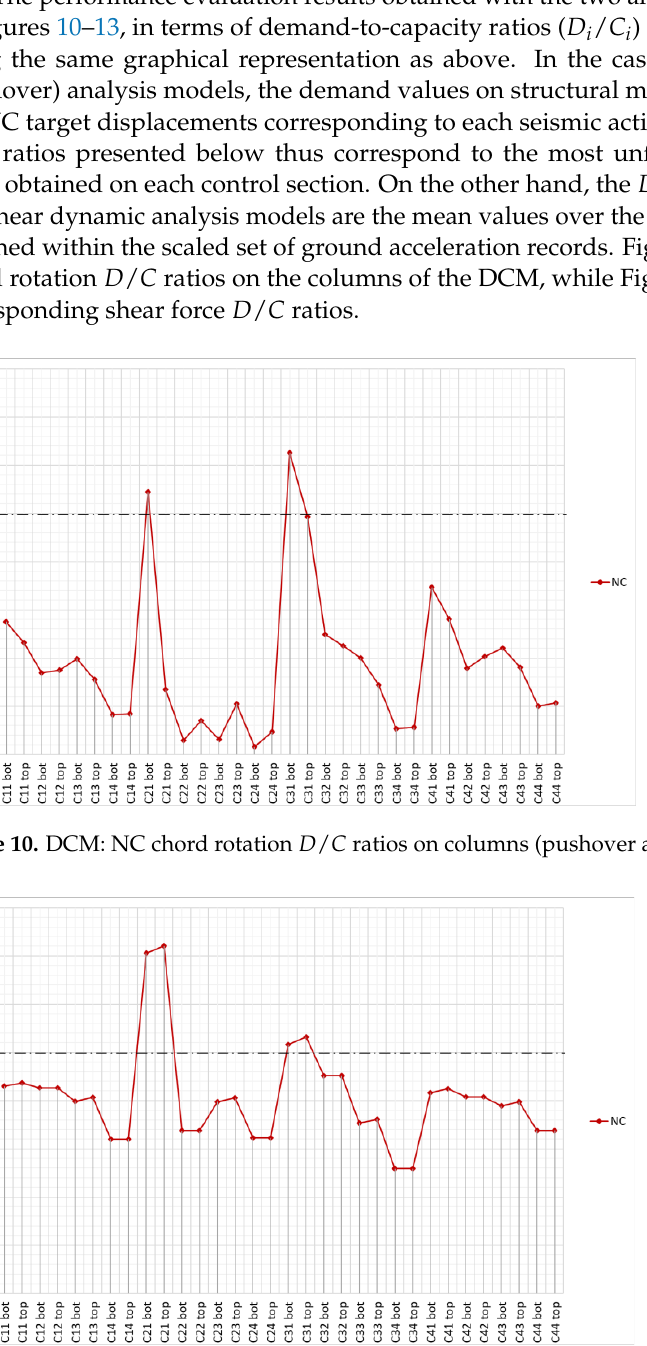
Figure 12. DCM: NC chord rotation 𝐷 𝐶⁄ ratios on columns (nonlinear dynamic analysis). Figure 13. DCM: NC shear force 𝐷 𝐶⁄ ratios on columns (nonlinear dynamic analysis).